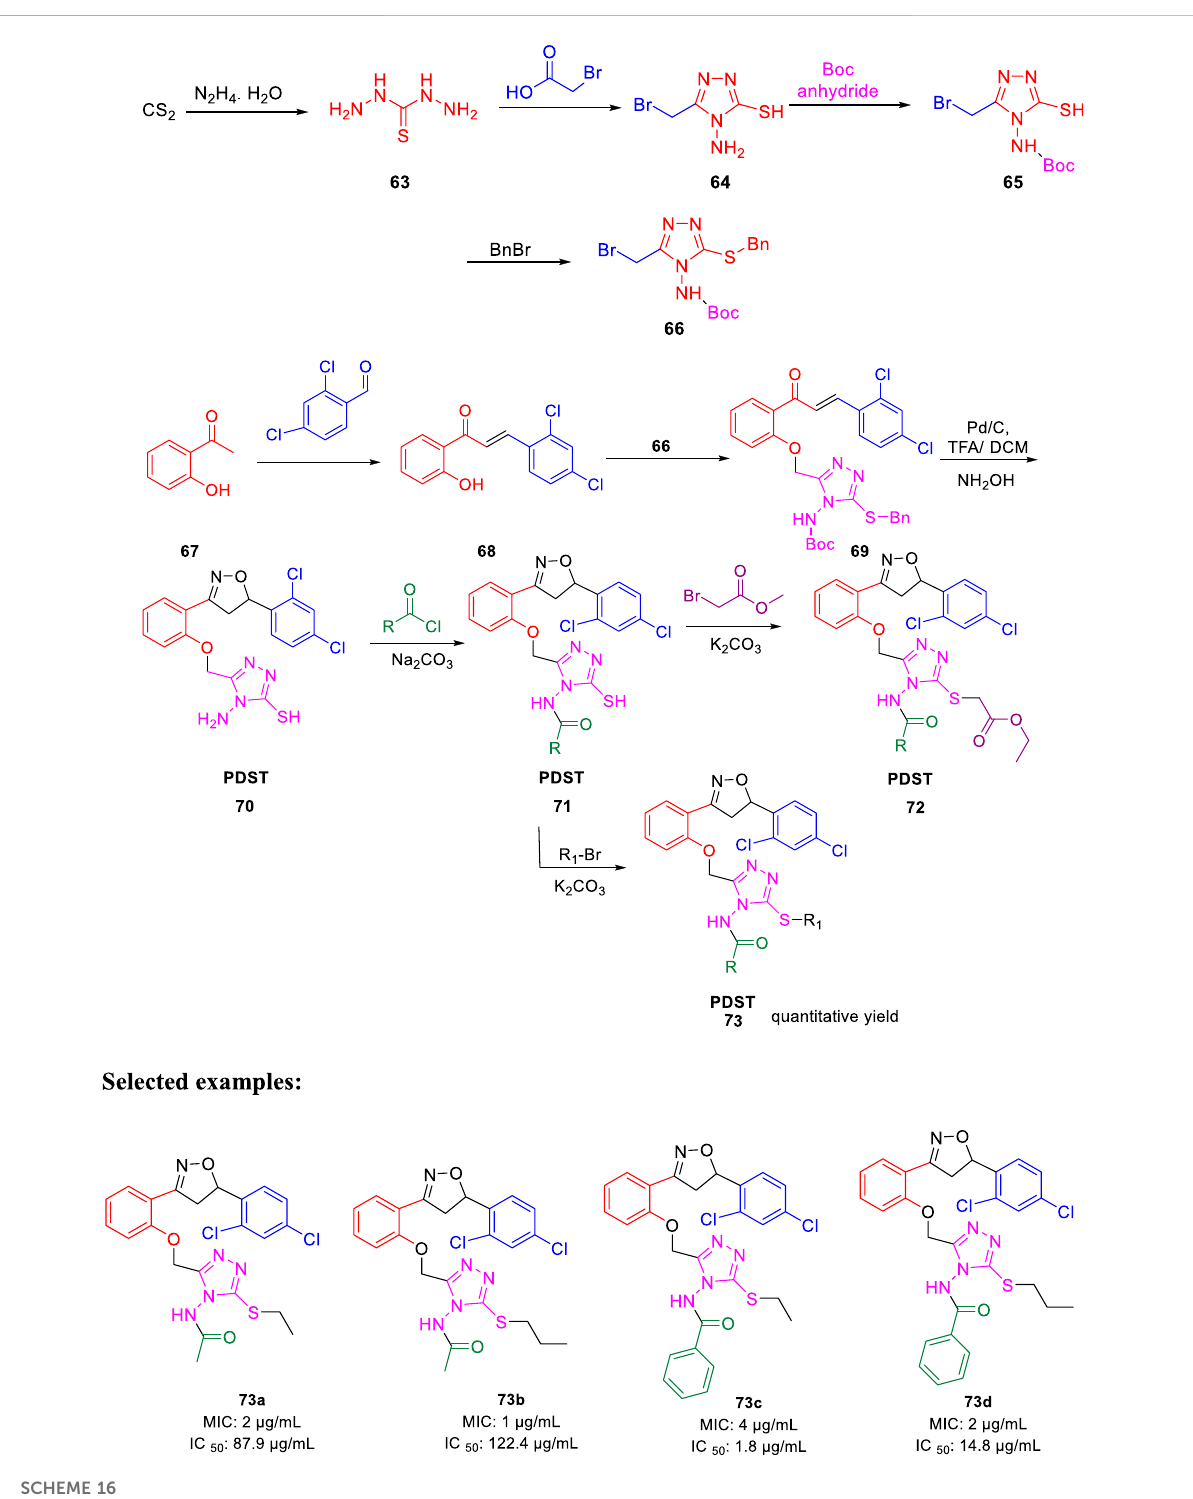
SCHEME 16 Multistep synthetic route to